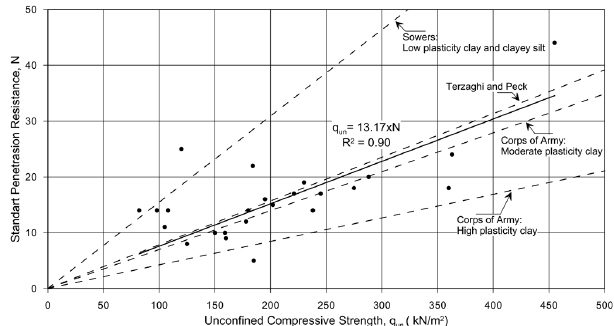
Fig. 12. Relationship between unconfined compressive strength and SPT (NAVFAC,